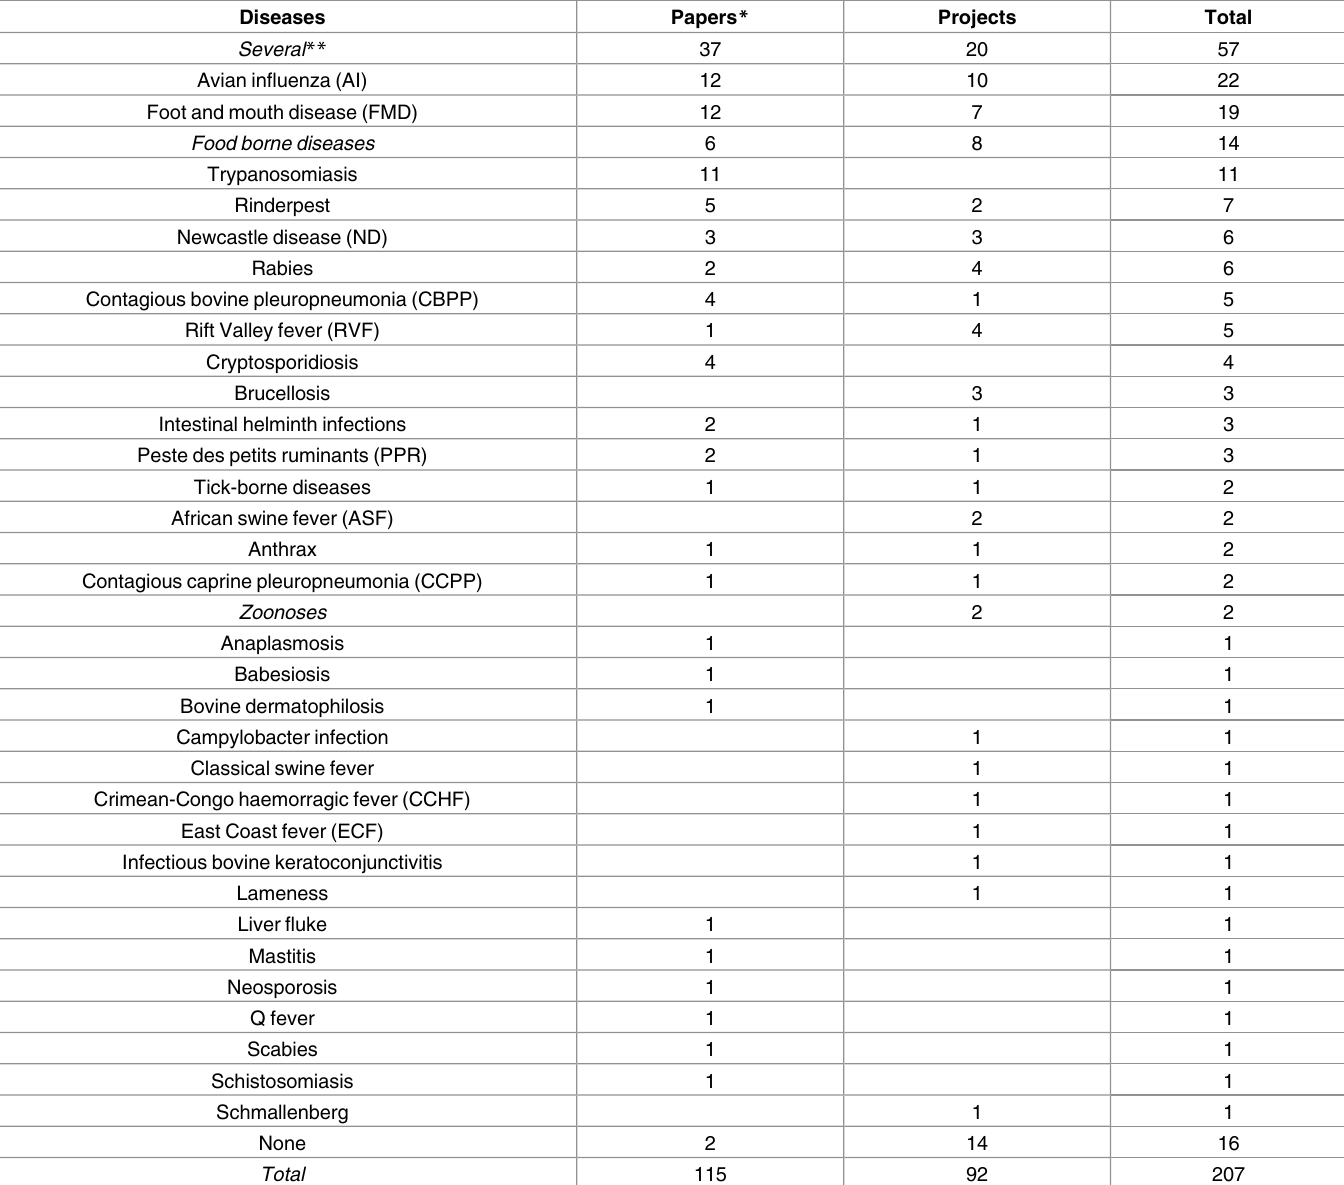
Table 2. Diseasescovered within the participatory epidemiology